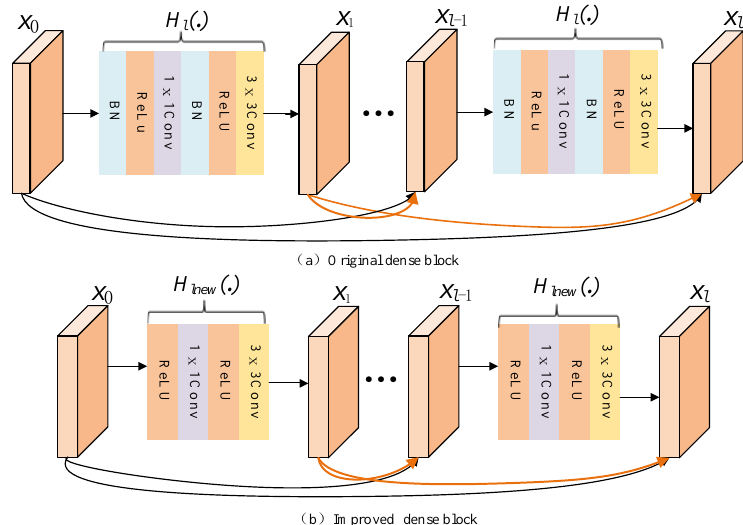
Figure 3. Comparison of the dense block between the original network and the proposed